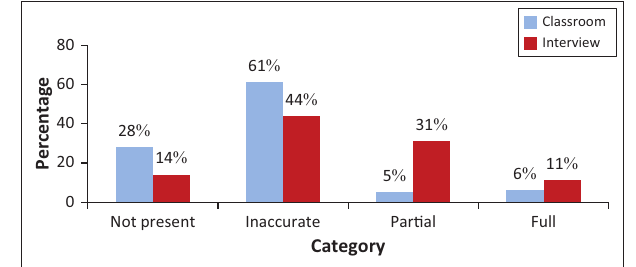
FIGURE 6: Diagnostic reasoning in relation to the error (averages across all rounds).